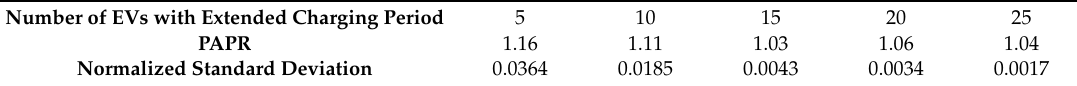
Table 3. The PAPR and the normalized standard deviation of the load profile.